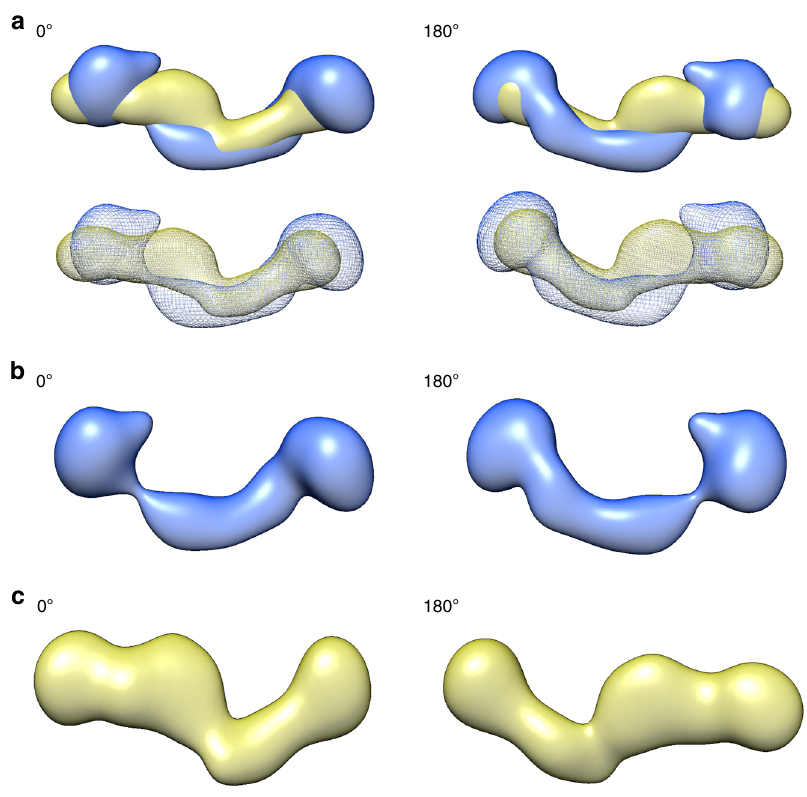
Fig. 7 Solution conformation of Bvht and its complex with CNBP. a Blue, averaged solution structure of Bvht only; yellow, averaged solution structure of Bvht- CNBP complex. b Bvht only. c Bvht -CNBP complex. Individual solution structures are presented in Supplementary Fig.